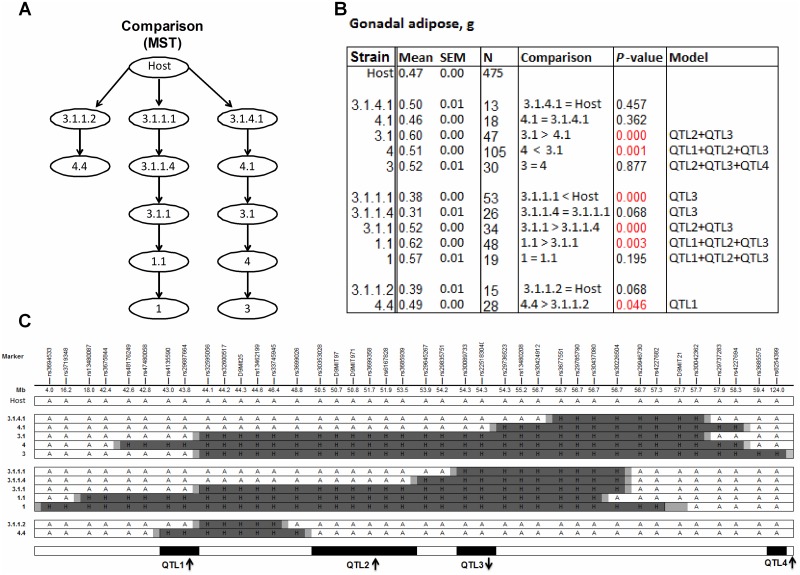
Dissection of QTLs with the congenic strains and the sequential method.(A) Minimum spanning tree (MST). (B) Mean and standard error of the mean (SEM) by strain for gonadal adipose depot weight in grams. Host = combined group of homozygous littermates without the donor fragment from all congenic strains; N = number of mice in each group. P-values are for least-significant-difference t-tests for each sequential comparison; red text indicates p-values that met the threshold (p<0.05). For the comparisons of two strains, the first strain was either greater (>), less than (<), or equal to (=) the second strain in gonadal adipose depot weight. “Model” lists QTLs within the donor fragment of each congenic strain suggested by the sequential analysis. (C) Congenic strains and genotypes for informative markers: A = B6/B6, shown as white bars; H = 129/B6, shown as dark gray bars; the recombinant ends correspond to both sides of the donor fragment for each congenic strain between H and A (or chromosome end), shown as light gray bars. QTLs are shown at the bottom as black boxes; arrows show the direction of effect (e.g., ↑ indicates that the QTL allele from the 129 strain increases the trait value). The data support the presence of four QTLs; we reported the detailed logic for this conclusion in S1 Text.